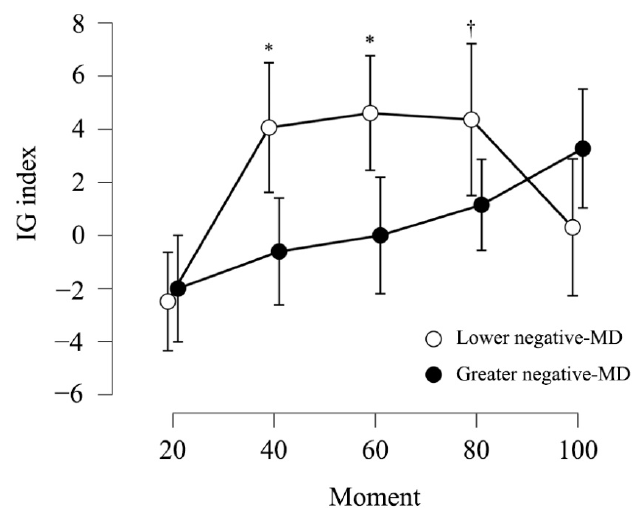
Figure 3. Performance in the IGT blocks depending on the group (higher or lower negative-MD). Participants who classified surprise or ambiguous faces as negative more directly, i.e., showed more negative bias at the implicit level, performed significantly better (*) in blocks 2 and 3 of the IGT. In addition, they showed a trend (†) towards better performance in block 4. Means ± 95% confidence Table 1. Inter-subject effect tests for the different IGT blocks.